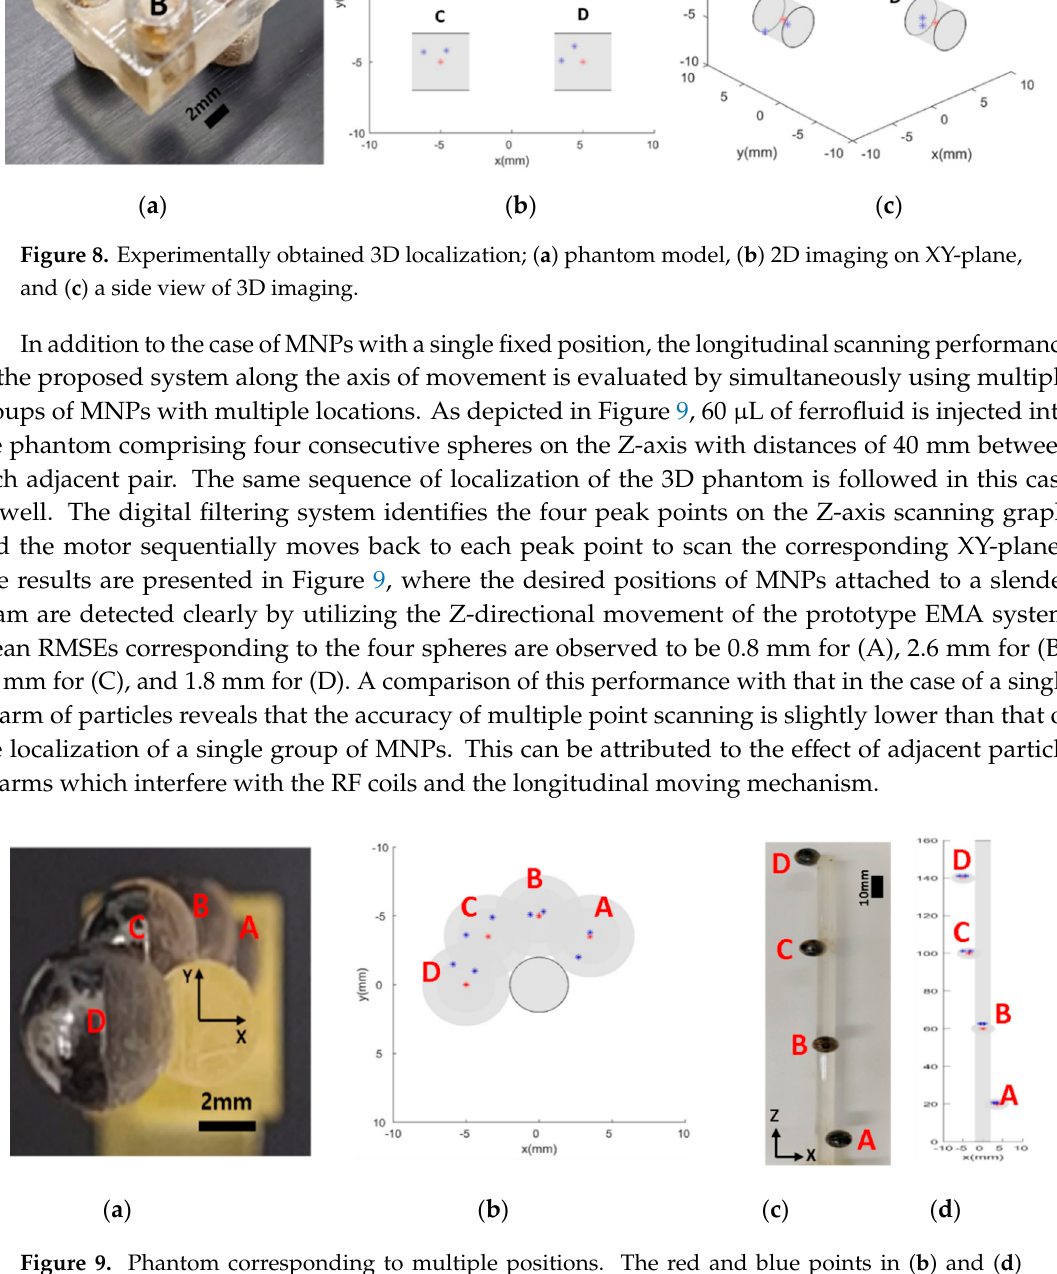
( b ) Figure 7. Comparison of locations of the highest intensity points of the particles and area. ( a ) The sequence of 2D scanning. ( b ) The reconstructed image based on the reflected signals. 4.3. 3D Localization To verify the performance of the proposed imaging mechanism and quantify the achieved resolution of MNP scanning in 3D space, a simple structured phantom comprising four cylindrical holes with diameters of 4 mm filled with EMG 707 is printed using Objet Eden260VS (Stratasys, Eden Prairie, MN, USA), as illustrated in Figure 8a. The desired intensity points corresponding to individual phantom holes in the 3D imaging experiment are taken to be (5, 5, 5), ( − 5, − 5, 5), (5, − 5, − 5), and ( − 5, 5, − 5). Because of the explicit focus on the localization of MNPs in this paper, the entire ROI was not scanned, unlike the case of conventional MPIs, which are equipped with at least three pairs of drive coils to actuate FFPs in a 3D workspace. We begin the process by identifying the position of the aggregated MNPs on the Z-axis